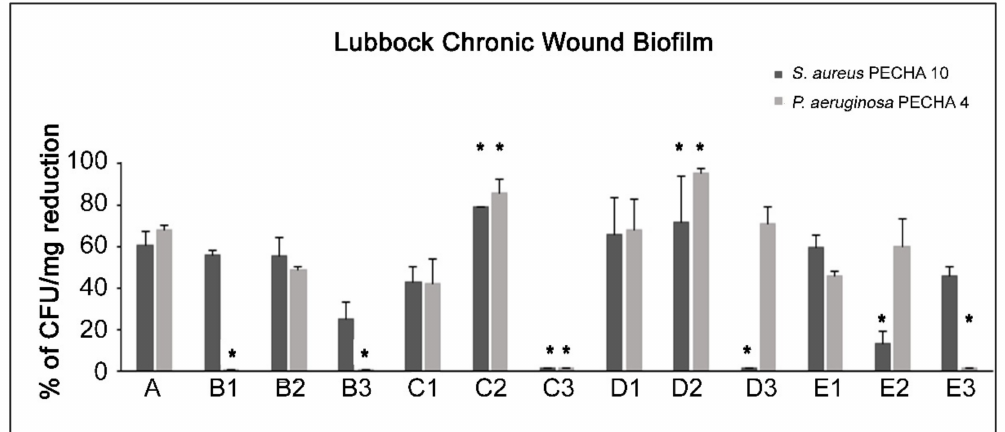
Figure 2. Percentages of CFU/mg reduction of S. aureus and P. aeruginosa in treated LCWB model versus the control. For the experimental points, see Figure 1 and the Section 4, paragraph 5. * Statistically significant difference ( p < 0.05) for each strain in respect to A